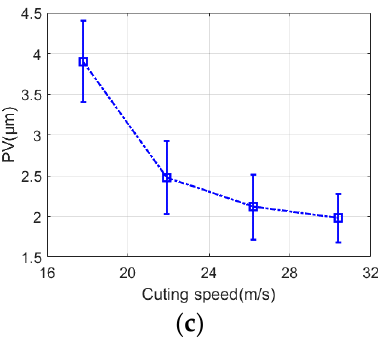
Figure 14. Effect of grinding marks on surface roughness under different grinding wheel linear speeds. ( a ) Ra . ( b ) RMS . ( c ) PV .